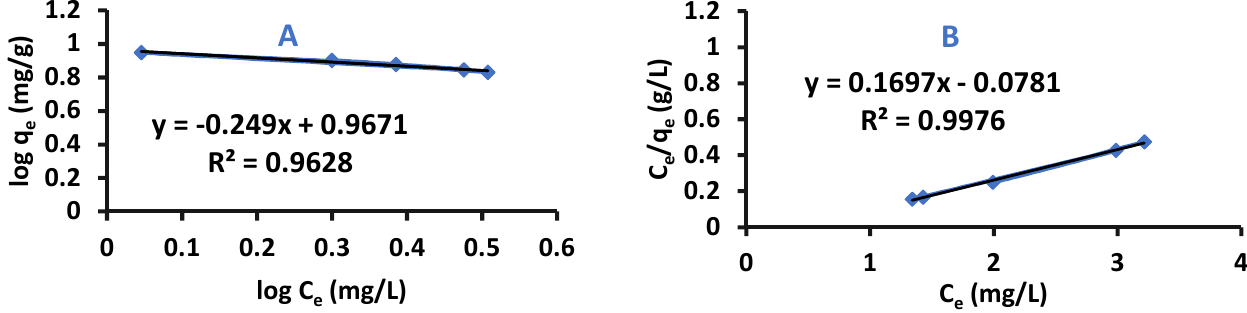
Figure 9. ( A ) Freundlich and ( B ) Langmuir plots for difenoconazole by Cell-D (pH: 4, volume: 10 mL, temperature: 20 °C, adsorption time: 15 min, dosage: 10 mg).